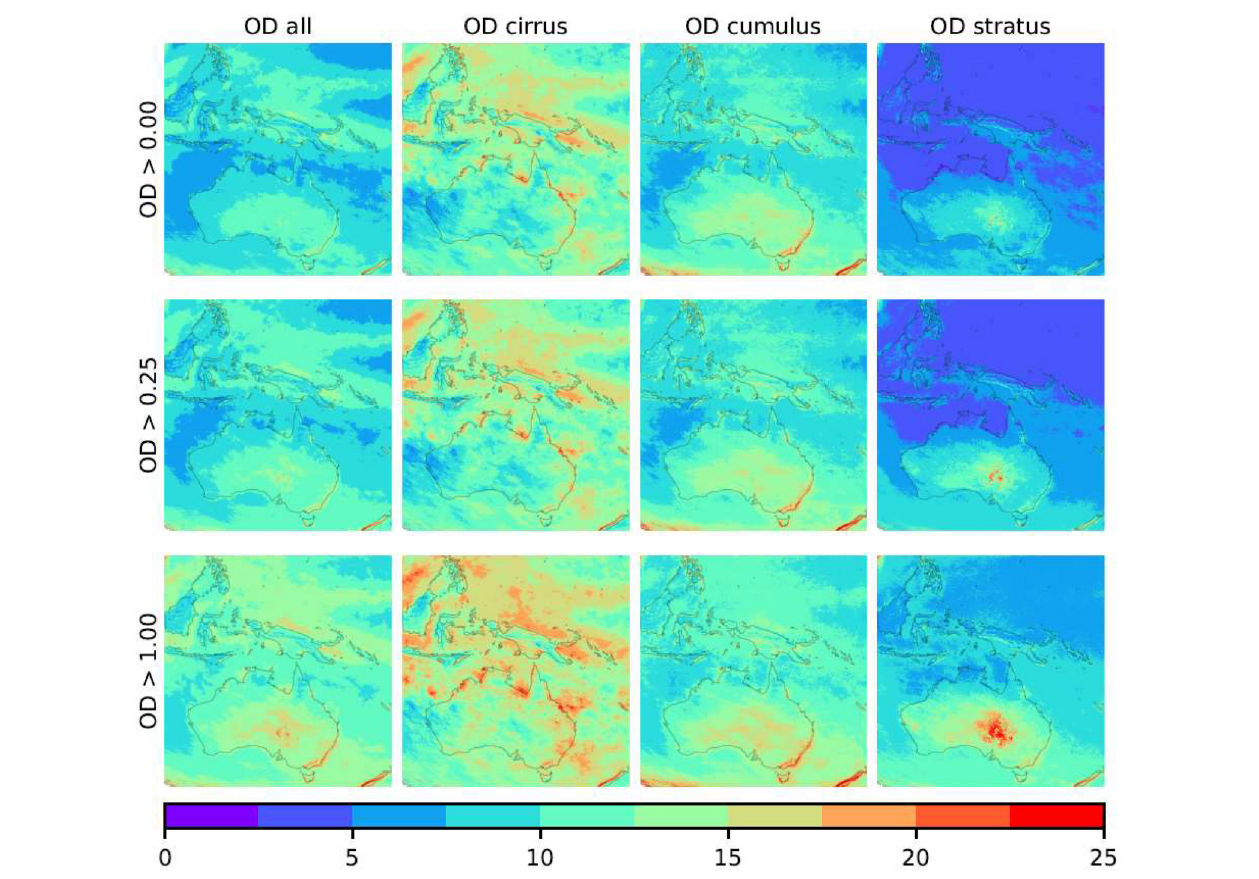
FIGURE 18 | Change of yearly mean cloud optical depth (OD) with lower OD thresholds: the top row shows all data; the middle row only when OD > 0.25; and the bottom row when OD > 1.0. Data obtained for the period from 1 Jan 2016 to 30 Nov 2017 for daylight hours from 22UTC to 8UTC (8–18 Australian east standard